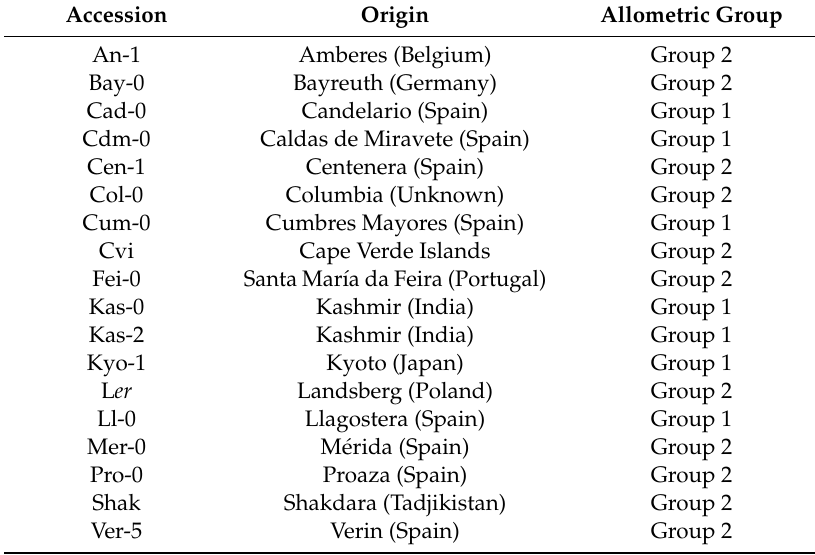
Table 1. Arabidopsis accessions used in this work, their geographical origin and allometric group. Accession Origin Allometric Group An-1 Amberes (Belgium) Group 2 Bay-0 Bayreuth (Germany) Group 2 Cad-0 Candelario (Spain) Group